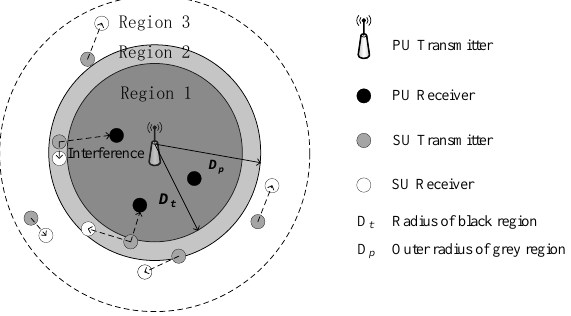
Figure 1. Geo-regions-based spectrum status identification.